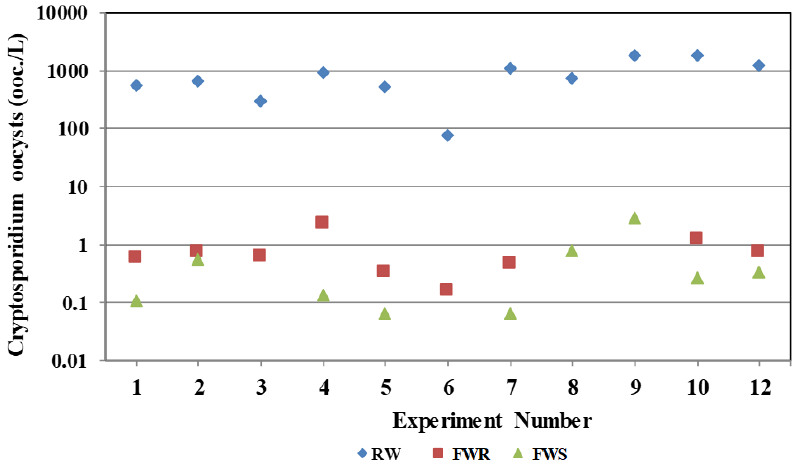
Figure 2. Cryptosporidium oocysts in raw and filtered water (RW—Raw Water; FWR—filtered water during ripening; FWS—filtered water during stable operation).